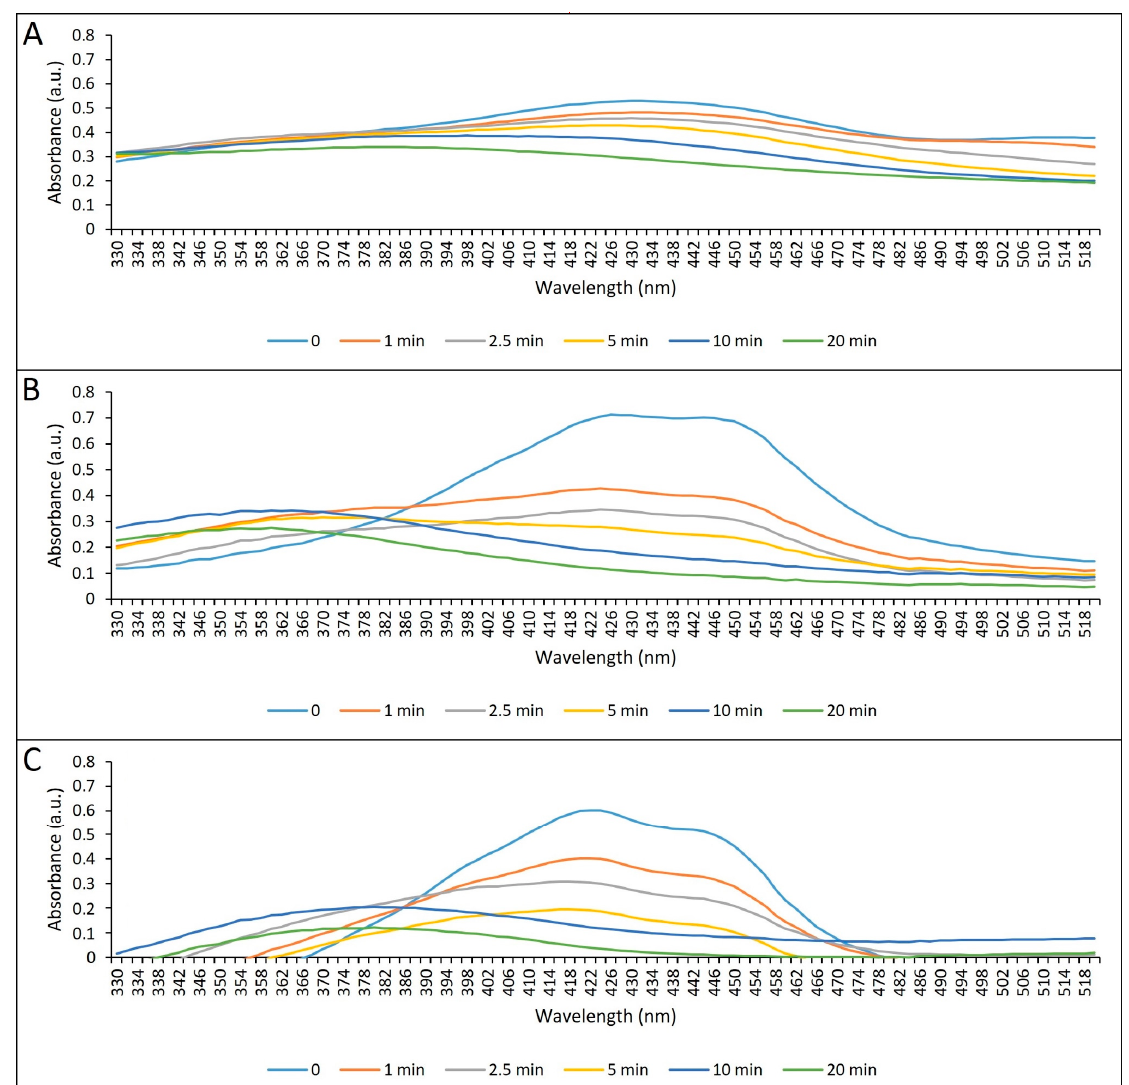
Figure 3. Photodegradation of free CUR, and anionic and cationic CUR-NPs after different periods of illumination with blue LED. ( A ) Free CUR; ( B ) anionic CUR-NP; ( C ) cationic CUR-NP.